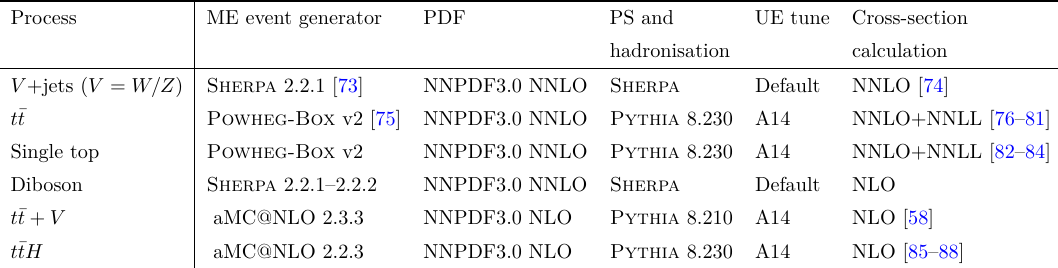
of cross-section calculations S